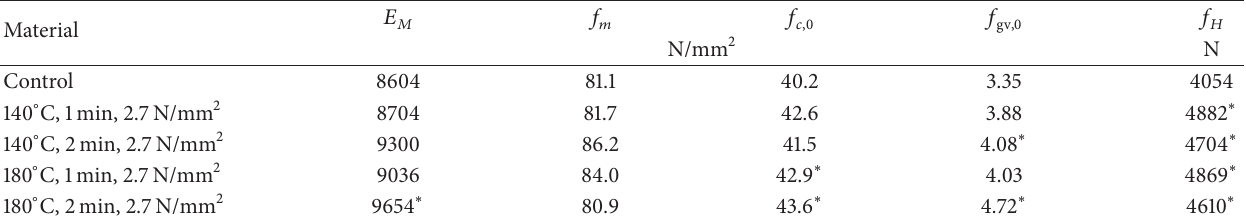
Table 4: Mechanical properties of plywood made from thermomechanically treated veneers. 𝐸 𝑓 𝑓 𝑓 𝑓 𝑀 𝑚 𝑐,0 𝐻 gv ,0 Material N/mm 2 N Control 8604 81.1 40.2 3.35 4054 140 ∘ C, 1min, 2.7 N/mm 2 8704 81.7 42.6 9300 86.2 9036 9654